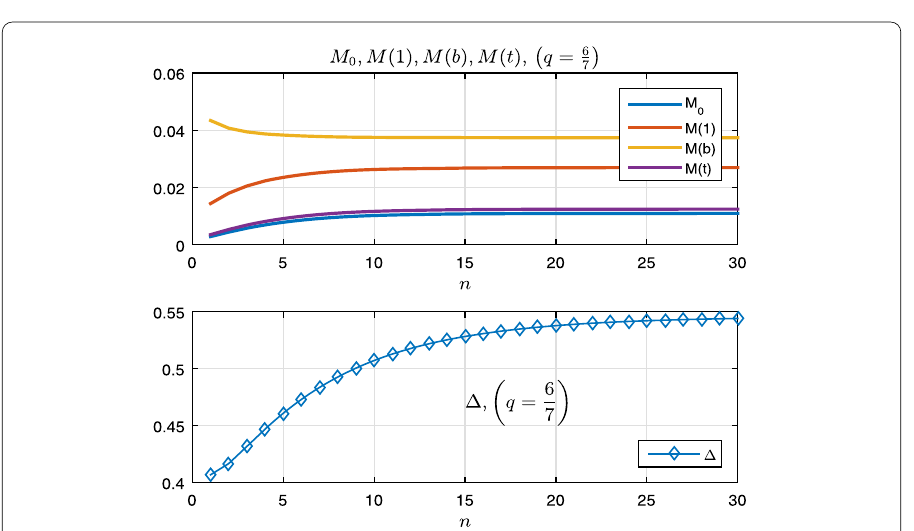
Figure 9 2D graphs of M 0 , M (1), M ( b ), M ( t ) on t ∈ J for q = 6